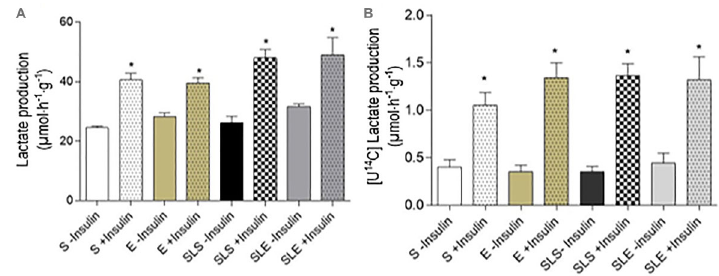
Figure 5. Total lactate ( A ) and radiochemical lactate ( B ) production from glucose in isolated incubated soleus muscles obtained from sedentary (S), exercise (E), small-litter sedentary (SLS), and small-litter exercise (SLE) rats. Muscles were incubated in Krebs-Ringer bicarbonate buffer, containing 5.6 mM glucose, 0.1 uCi/mL D-[U 14 C] glucose, for 1 h in the absence or presence of 10 mU/mL insulin. Data are reported as means ± SE (n=8). *P o 0.05 vs non-stimulated